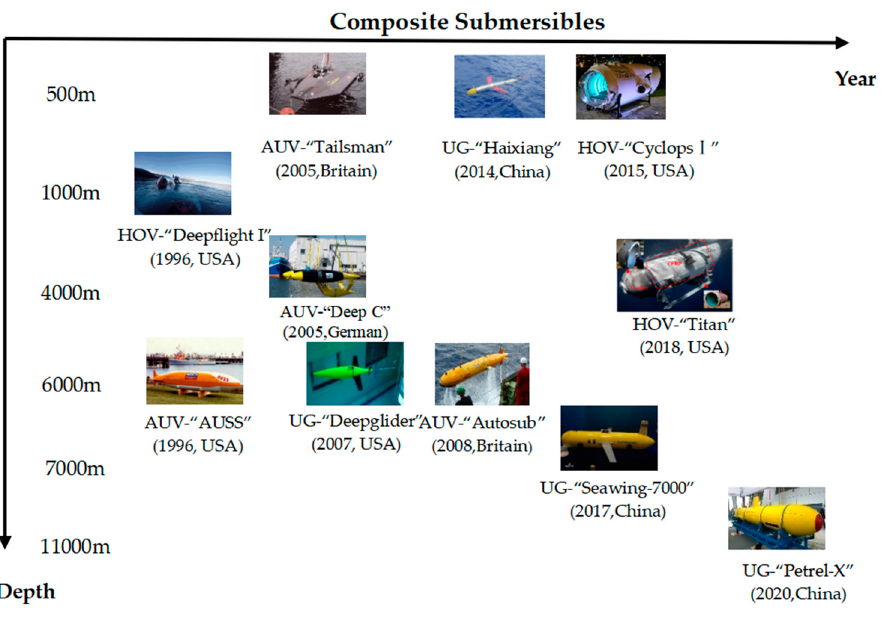
Figure 1. Composite materials being used in submersibles worldwide.